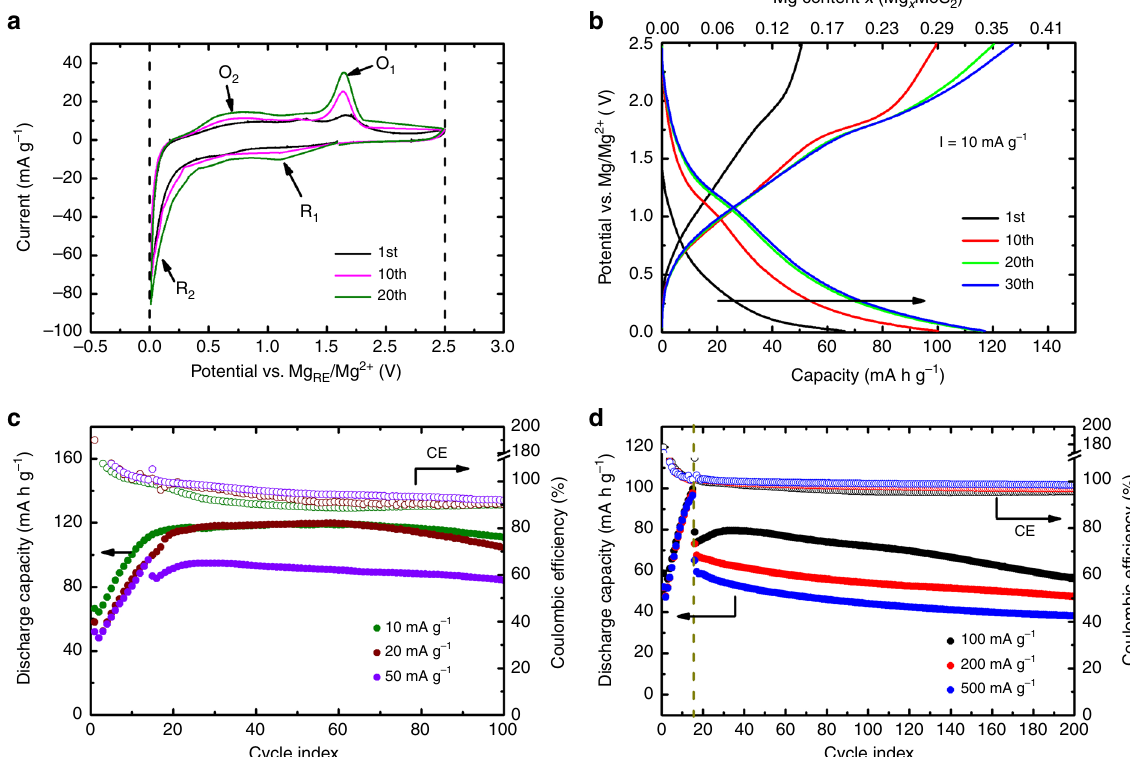
Fig. 2 Electrochemical performance of MoS 2 @C-PNR. a Three-electrode CV (vs Mg RE /Mg 2 + ) at a scan rate of 0.1 mV s − 1 between 0.01 and 2.5 V; b selected cycles of galvanostatic cycling at 10 mA g − 1 ; c , d cycling performance at different current rate, for measurements running at 50, 100, 200 and 500 mA g − 1 , the cells were activated at 20 mA g − 1 for 15 cycles before applying corresponding